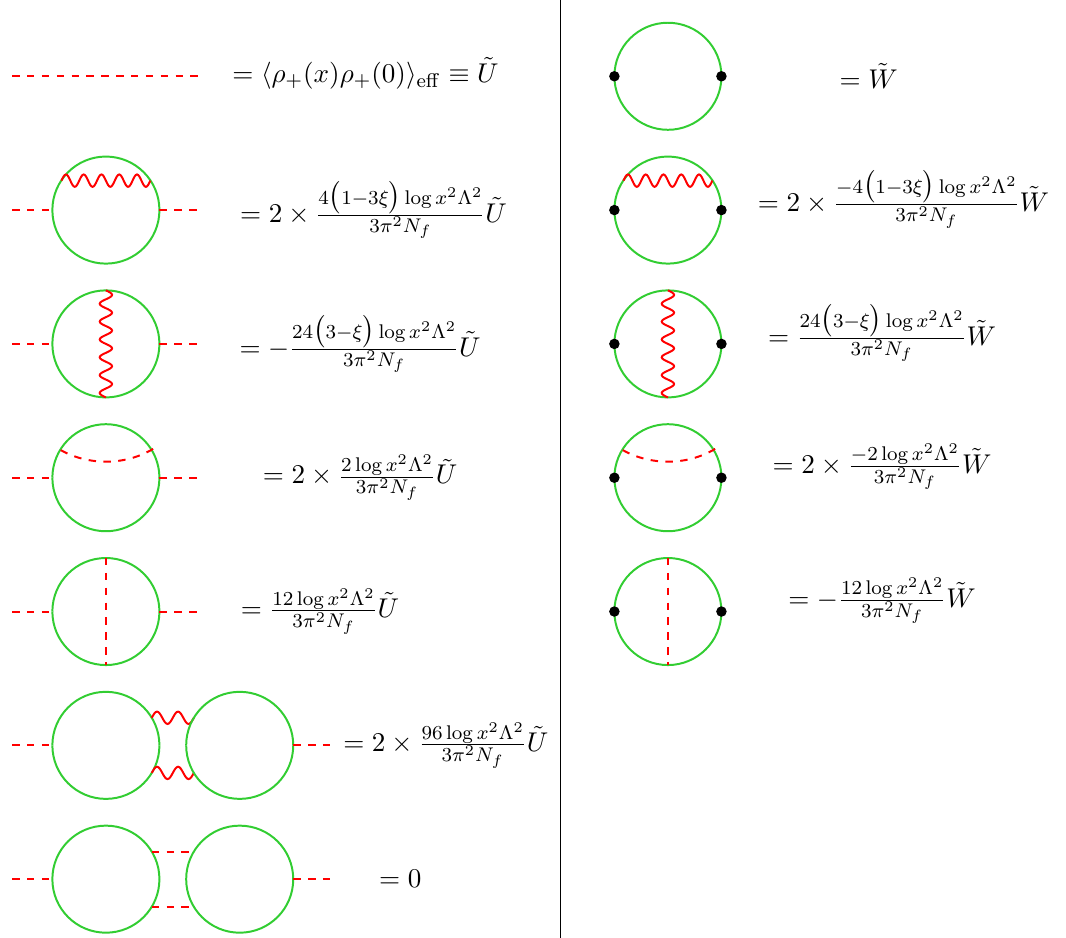
Table 10 . (QED-GN + ) Results for individual Feynman graphs appearing in the 2-point correlation functions h (cid:26) + ( x ) (cid:26) + (0) i (left column) 13 and hj (cid:9) j 2